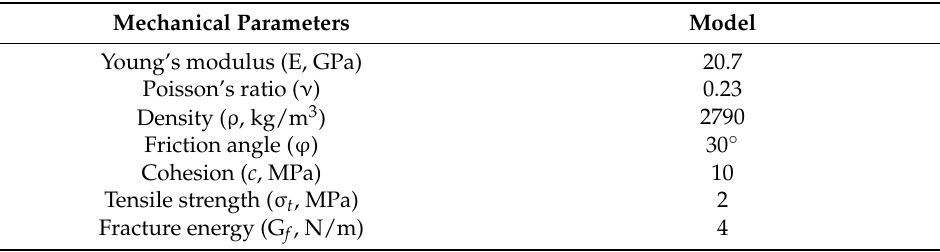
Figure 17. Loading schematic of model. Table 9. Material properties adopted in model. Table 9. Material properties adopted in